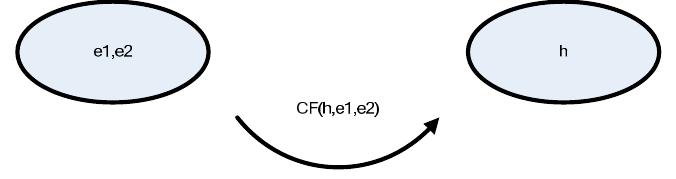
Figure 4. The result of the simplification based on formulas (5) or (6).